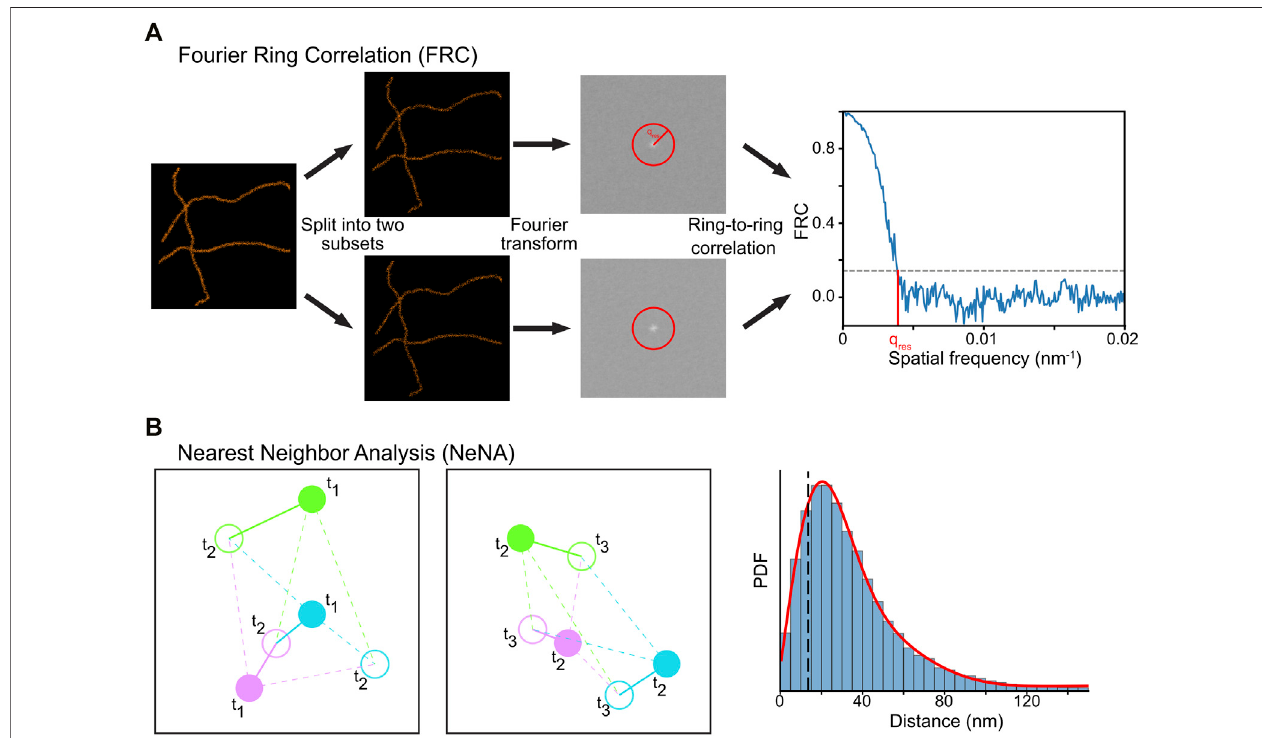
FIGURE 9 | Computational methods to determine resolution in SMLM. (A) In FRC, the localization data is split randomly in two subsets, and the correlation of the Fourier transforms of these images at rings with increasing radius is calculated. The resolution of the dataset can then be calculated by determining where the FRC crossesthevalueof1/7. (B) InNeNA,positionsofidenticalemitterslocalizedinsubsequentframesarecomparedwitheachother,andthedistributionofthesedistances is fi tted with a non-central chi distribution. This fi t provides a measure for localization